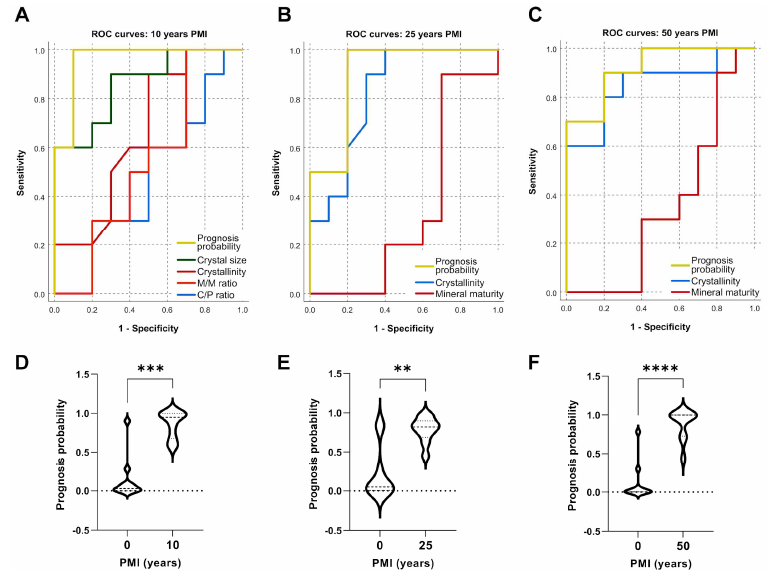
Figure 5. Receiver operating curve (ROC) and prognostic probability analysis predicting the post- mortem interval (10, 25 and 50 years) in human teeth. ( A ): ROC Curve for 10 years of postmortem interval. ( B ): ROC Curve for 25 years of postmortem interval. ( C ): ROC Curve for 50 years of postmortem interval. ( D ): Prognosis probability for 10 years of postmortem interval. ( E ): Prognosis probability for 25 years of postmortem interval. ( F ): Prognosis probability for 50 years of postmortem interval. **/***/**** p < 0.01/0.001/0.0001 versus control